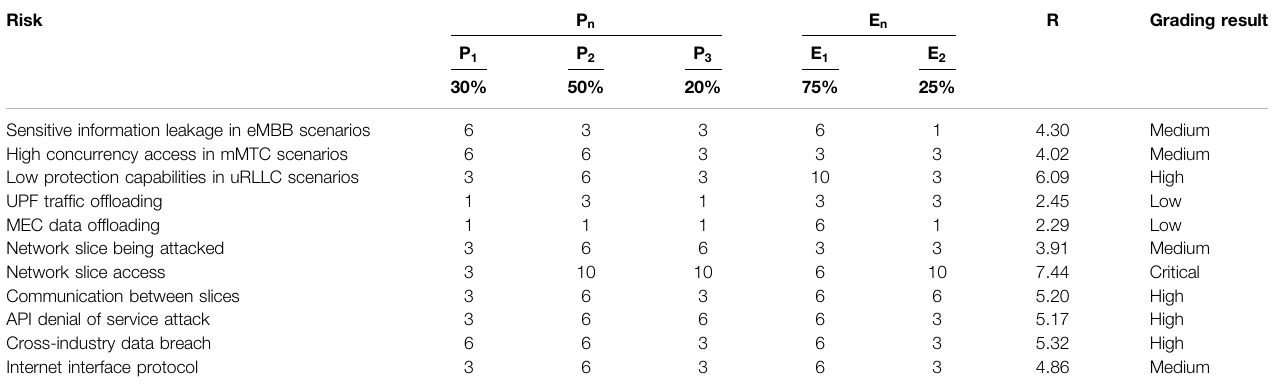
TABLE 3 | Risk assessment of power 5G hybrid networking. Risk P